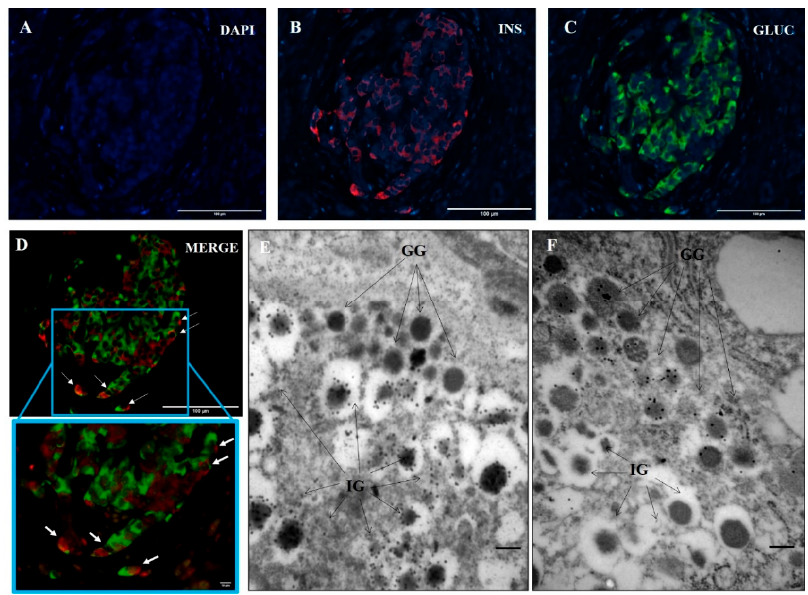
Figure 1. Representative images showing insulin and glucagon double positive (Ins + /Glu + ) cells in human type 1 diabetes (T1D) pancreatic islets. Fluorescence microscopy images of DAPI ( A ), DAPI/insulin ( B ) and DAPI/glucagon ( C ) immunostainings are shown, with a few cells containing both insulin and glucagon positivity indicated in ( D ) (scale bar in A-D corresponds to 100 μ m); electron microscopy images of insulin ( E ) and glucagon ( F ) immunogold staining (scale bar corresponds to 0.26 μ m). IG: insulin granules; GG: glucagon granules.